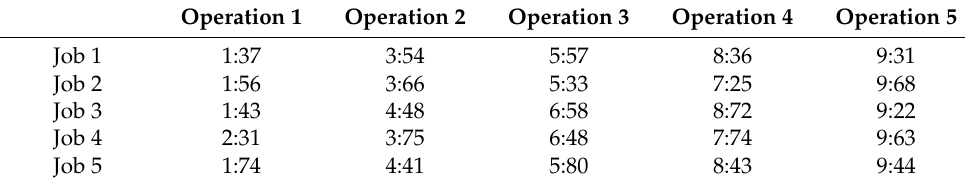
Figure 4. ( a ) Logic simulation environment. ( b ) 3D visualization model. Figure 4. (a) Logic simulation environment. (b) 3D visualization model. Table 2. Case test